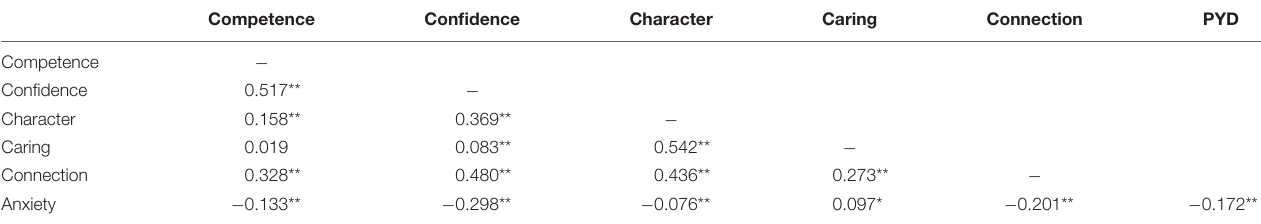
TABLE 5 | Correlation coefficients between the 5Cs and anxiety in the Spanish sample.